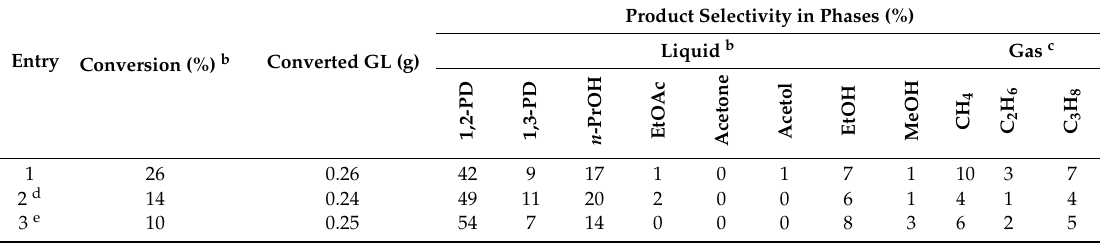
Table 2. Recycling of Ru-WD catalyst in GL hydrogenolysis a